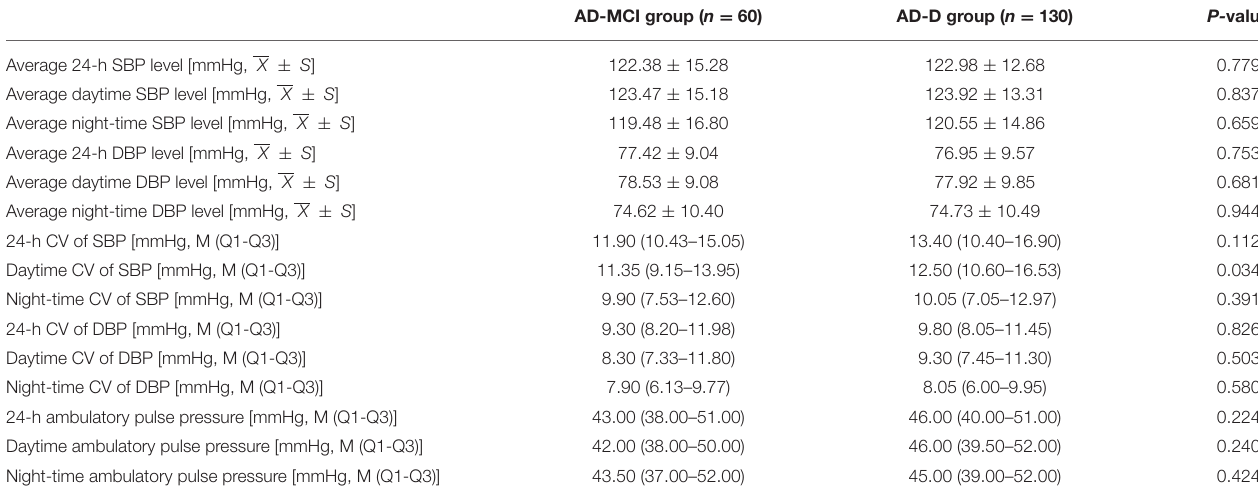
TABLE 2 | Comparisons of 24-h ambulatory BP variables between the AD-MCI and AD-D groups.